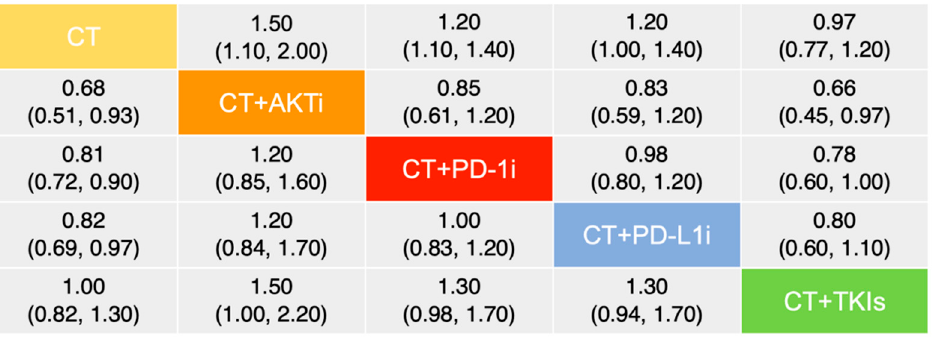
Figure 3. Comparative analysis of progression-free survival among selected therapies. Data are presented as hazard ratio and 95% credible interval. The upper right values display the top treatment compared to the bottom treatment. The lower left values demonstrate the converse comparisons. Abbreviation: AKTi, Protein kinase B inhibitor; CT, Chemotherapy; PD-1i, Programmed cell death protein 1 inhibitor; PD-L1i, Programmed cell death ligand 1 inhibitor; TKIs, Tyrosine kinase inhibitors.